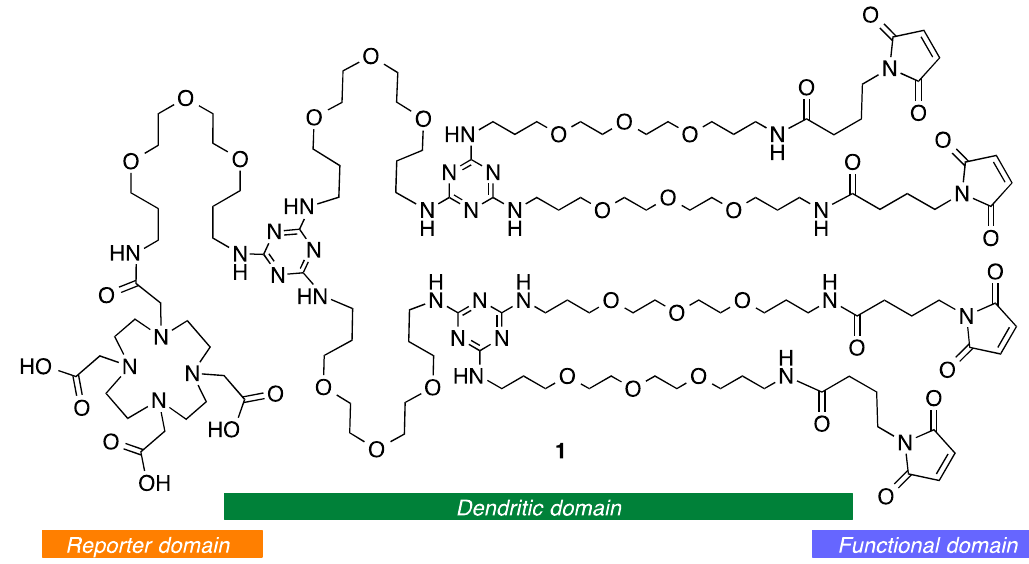
Chart 1. Target 1 with domains identified as reporter domain ( orange ), dendritic domain ( green ) and functional domain ( blue ).